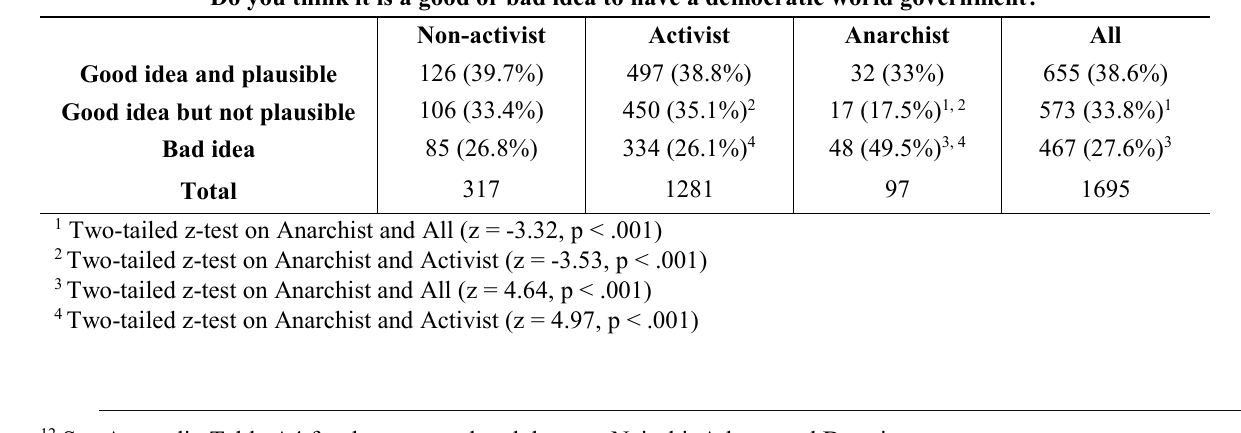
Table 7: Democratic World